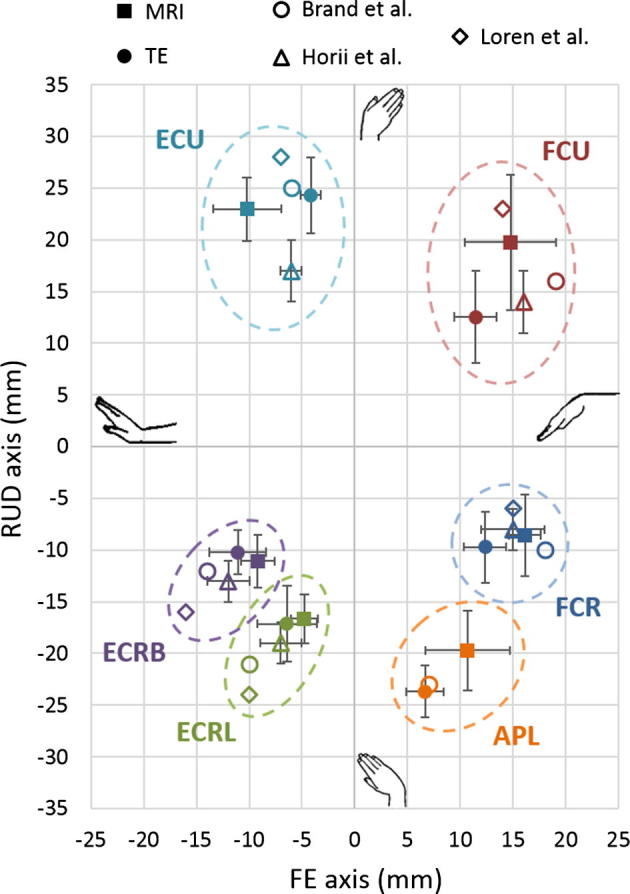
Comparison of moment arms in flexion extension (FE) and radioulnar deviation (RUD) obtained using magnetic resonance imaging (MRI) and the tendon excursion method (TE) for 10 specimens with data from Brand and Hollister (1993) for 11 specimens, Horii et al. (1993) for 7 specimens and Loren et al. (1996) for 5 specimens for the flexor carpi radialis (FCR), flexor carpi ulnaris (FCU), extensor carpi radialis longus (ECRL), extensor carpi radialis brevis (ECRB), extensor carpi ulnaris (ECU), abductor pollicis longus (APL).